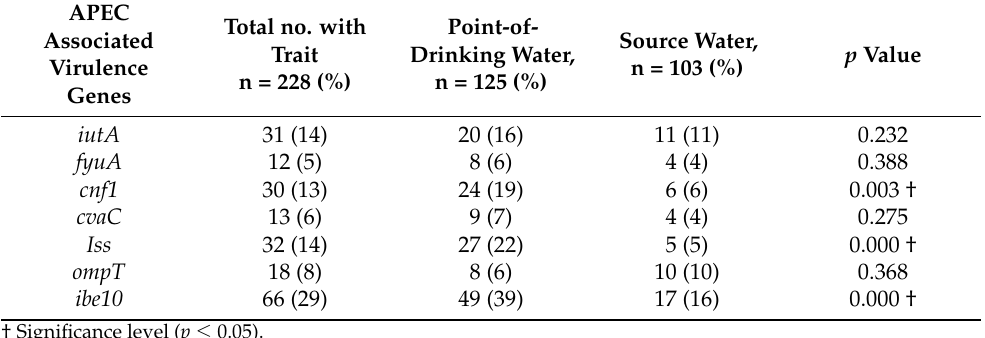
Table 4. Presence of APEC-associated genes among the 228 E. coli isolates from the point-of-drinking water and the source water in Arichpur, Dhaka collected from September 2014 to October 2015.